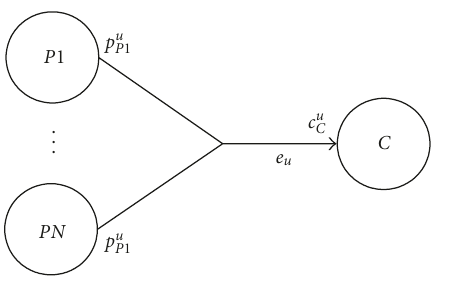
Figure 6: The multiple producers special channel with producers P 1, ... , PN has no CSDF equivalent as the token order depends on the response time.